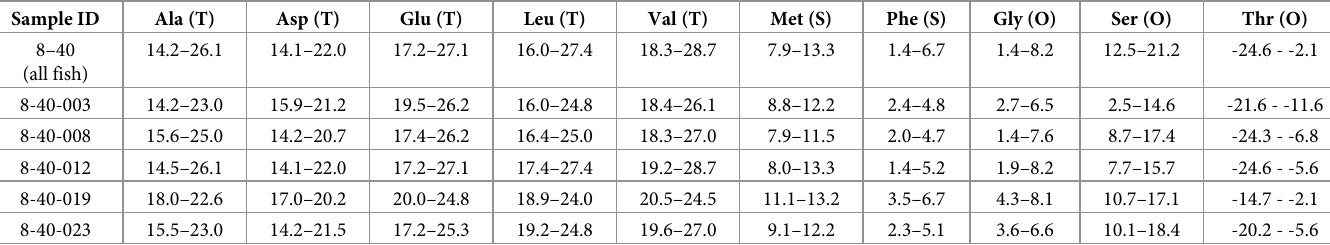
Table 4. Amino acid δ 15 N values ( δ , in ‰) for Red Snapper individuals from station 8–40. Sample